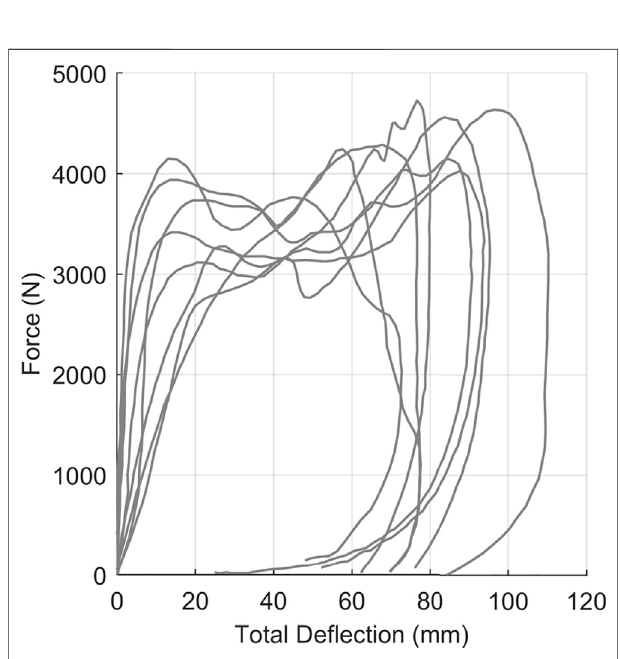
FIGURE 8 | Kroell et al. thoracic impact response signals collected from eight post-mortem human subjects.